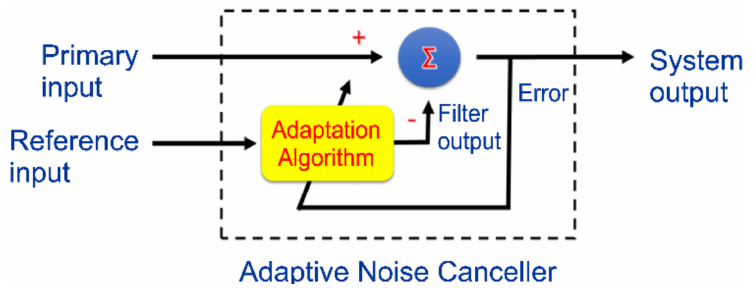
Figure 1. Schematic of an adaptive filter (modified from [21] and references